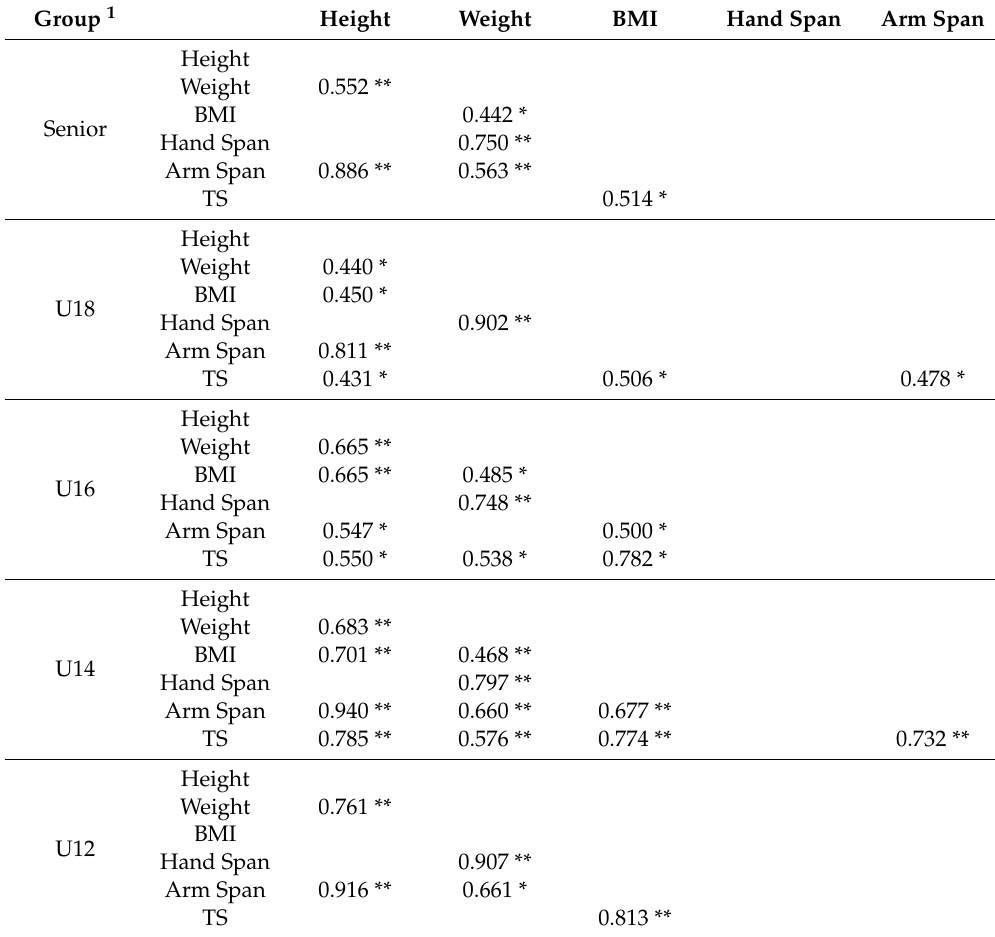
Table 2. Pearson’s linear partial correlation for each variable.